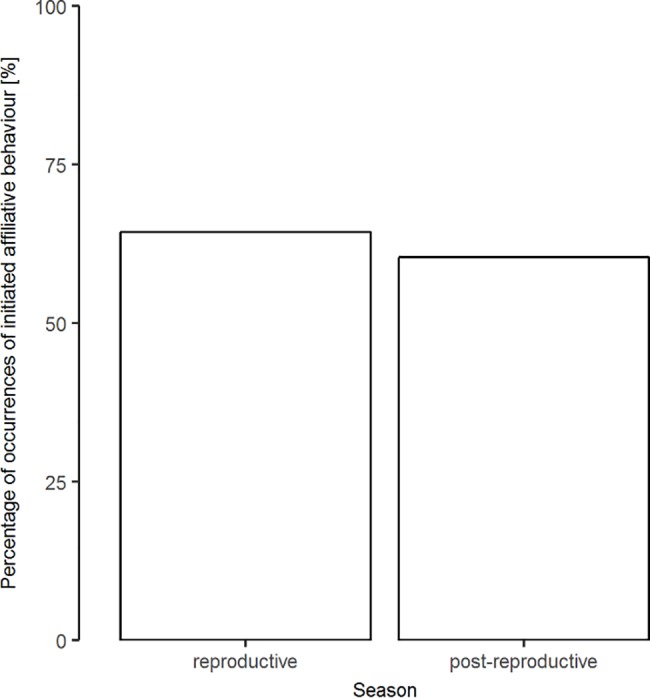
Seasonal differences in engaging in affiliative interactions.Percentage of occurrences of initiated affiliative behaviour for the reproductive and post-reproductive season. Nreproductive = 87, Npost-reproductive = 197.